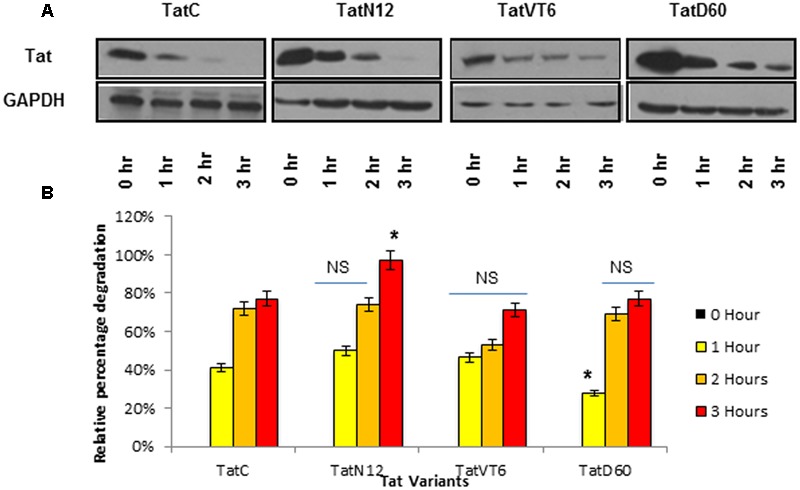
Intracellular stability of Tat variants. HEK293 cells were transfected with pCMV-Myc Tat variants and wild-type TatC, cycloheximide (100 μg/ml) was added after 24 h and cells were harvested at different time intervals and immunoblotted with anti-Tat antibody. The relative percentage of Tat protein degradation was measured using ImageJ software. Wild-type TatC was used as a reference Tat for comparison. Tat proteins expressed after 24 h of transfection (before adding cycloheximide) were used as controls. GAPDH was used as a loading control. (A) Relative protein expression of Tat variants and wild-type TatC at different time intervals. (B) Quantification of Tat protein degradation normalized to GAPDH. Error bar represents the standard deviation in triplicates. Statistical comparison of each Tat variant to Tat C was calculated by one-way ANOVA with the Tukey’s test (∗ denotes P < 0.05 and NS denotes not significant).